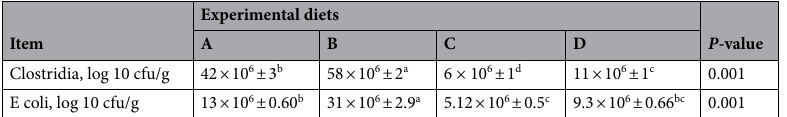
Table 7. Effect of DETOXIZYME supplementation on Clostridia and E Coli accounts under clostridia infection in Cobb 500 broilers. a–c The means values placed at the rows by different superscript letters are significantly different (P < 0.05). Values are expressed as means ± standard error. Abbreviations: (A) control negative (basal diet), (B) control positive (basal diet supplemented with clostridia infection), (C) control positive group diet with 100 g DETOXIZYME/ton of feed, (D) control negative diet group with 100 g DETOXIZYME/ton of feed.